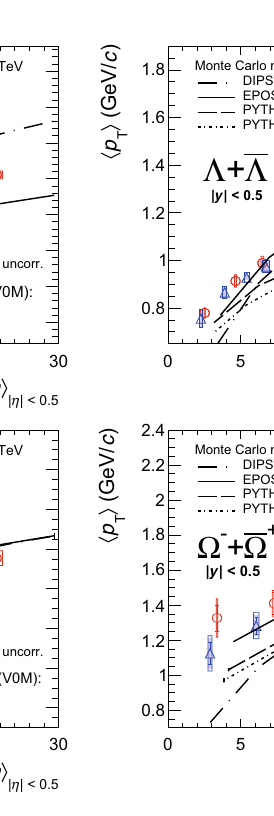
Shadowed boxes represent uncertainties uncorrelated across multiplic- ity. The results are compared to predictions from several Monte Carlo